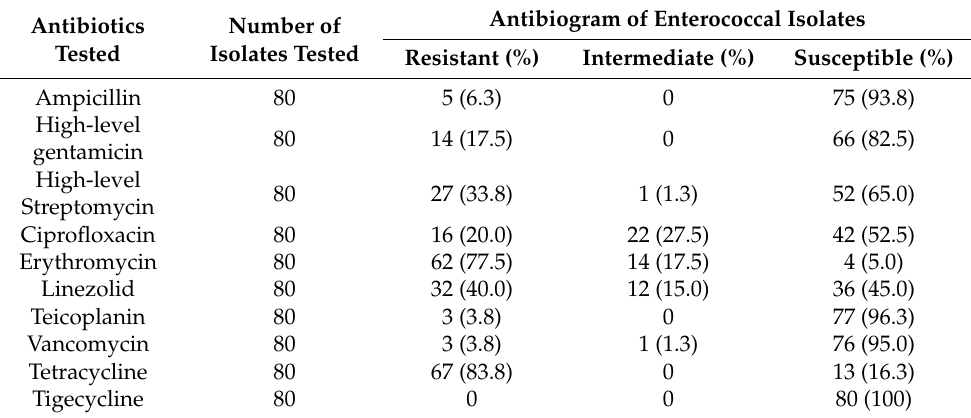
Table 1. Antibiogram of enterococcal isolates recovered from a poultry farm environment in